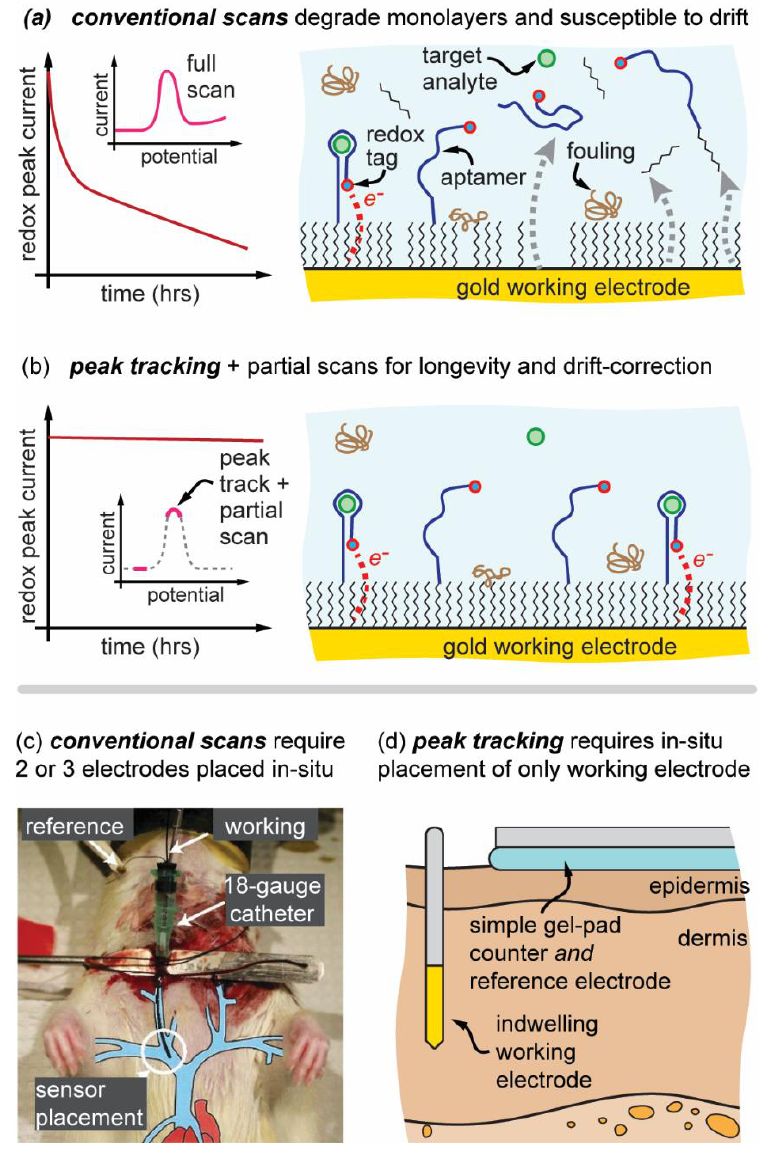
Figure 1. Improvements to traditional sensing techniques through software improvements. ( a ) Conventional E-AB methods susceptible to electrochemically accelerated monolayer desorption and monolayer fouling that can reduce signal and utility whereas ( b ) automatic-peak-tracking improves sensor longevity. ( c ) Conventional in vivo EAB sensing requires more complicated 3-electrode placement inside the body, reproduced from [12] compared to ( d ) auto-peak tracking EAB allows simplified use of a single working electrode in the body.